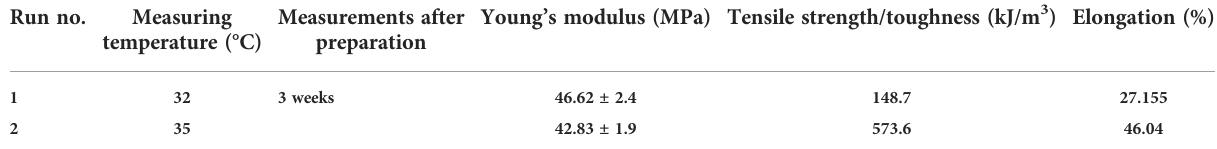
TABLE 1 Mechanical properties of the bioplastic sample in different conditions associated with the Young ’ s modulus, toughness, and elongation. Run